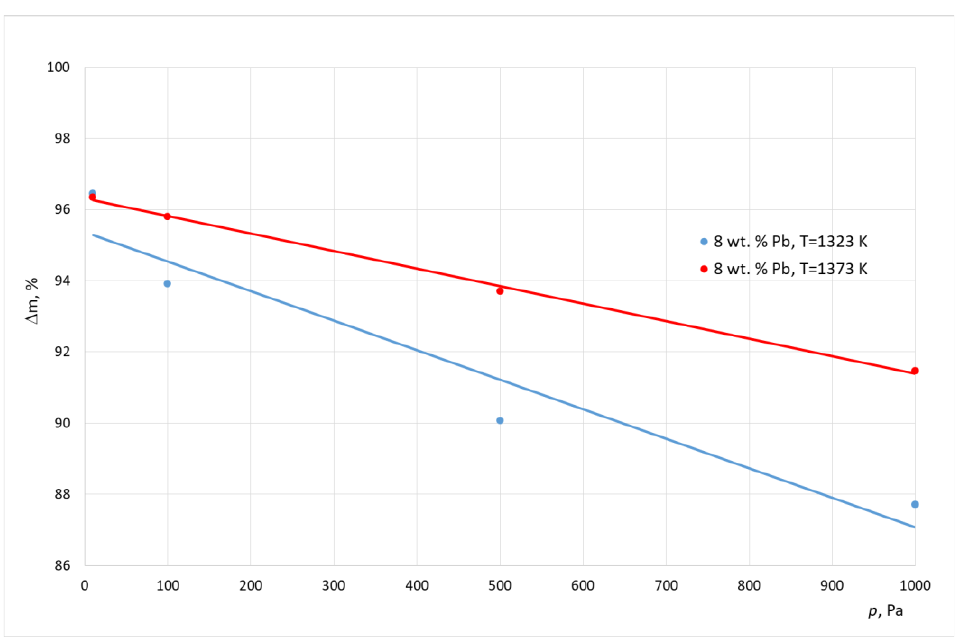
Figure 2. Relative mass loss of lead during smelting realized inside ICF, with different working pressures (alloy 8 wt. % Pb).